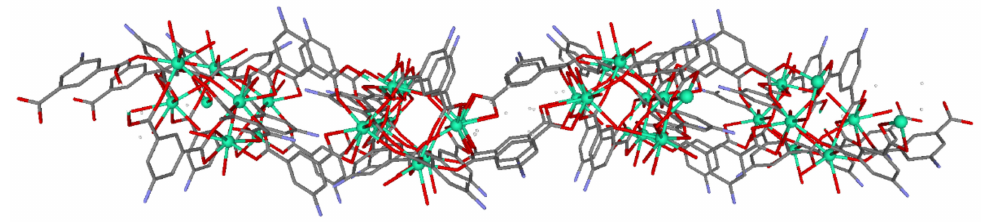
Figure 2. Bidimensional structure for compound 2 . Crystallization molecules and hydrogen atoms are omitted for clarity. Color coding: grey = C, green = Dy, blue = nitrogen, red =